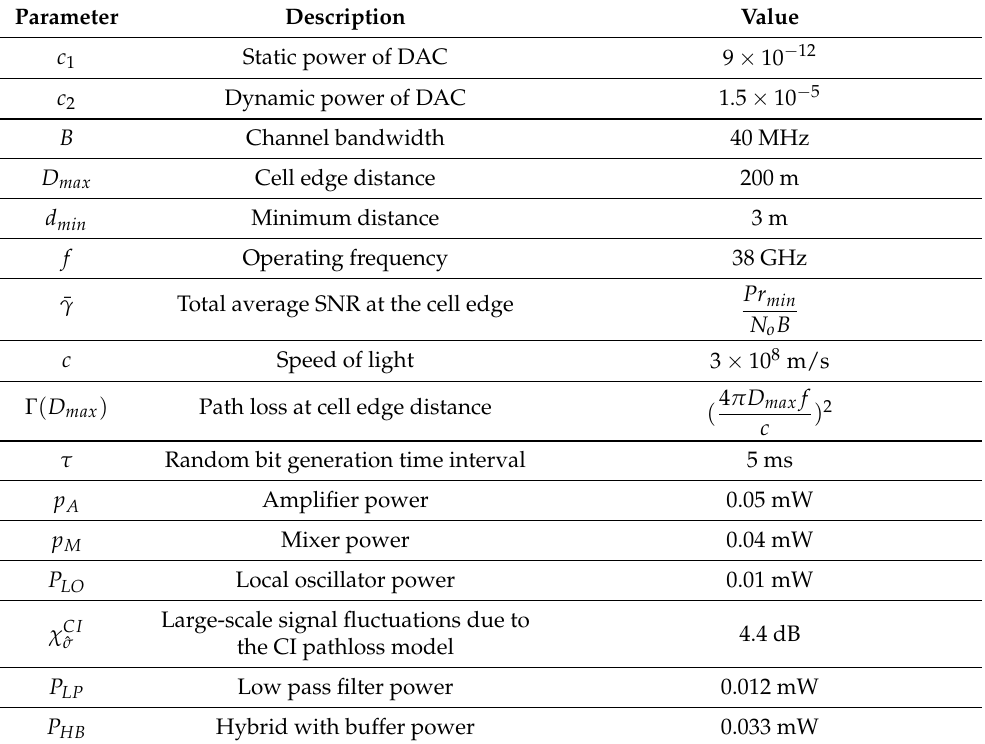
Table 2. Simulation